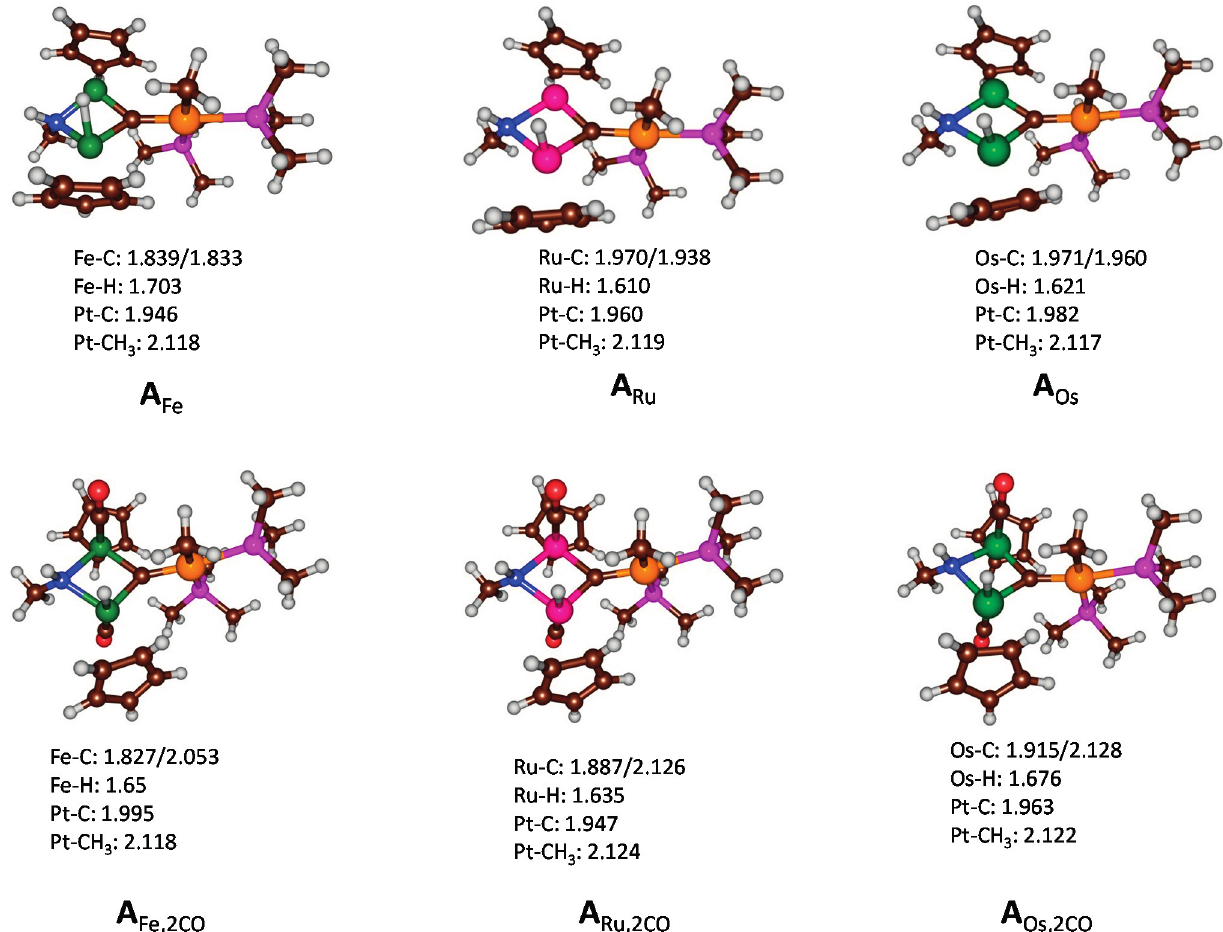
Figure 1. Optimized geometries of reactant complexes without CO ( top row ) and with 2 CO molecules bound ( bottom row ) as obtained by density functional theory